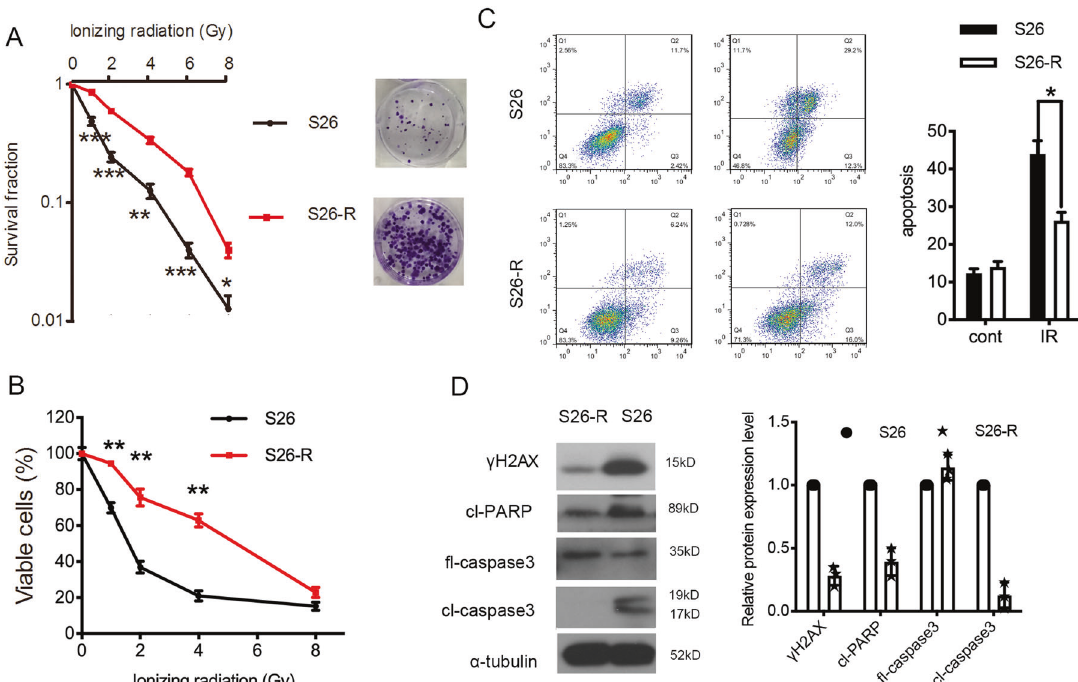
Fig. 1 Repeated ionizing radiation induces a risk of radioresistance in NPC cells. A (Left) Cell survival curve for treatment with increased doses of ionizing radiation in S26 and S26-R cells, * p < 0.05, ** p < 0.01, Student ’ s t -test. (Right) representative images of colonies formed after treatment with the indicated dose of ionizing radiation in S26 and S26-R cells. B A cell proliferation curve was constructed from the MTS assay results, data are presented as the mean ± S.D. values, ** p < 0.01, Student ’ s t -test. C , D S26 and S26-R cells were treated with or without 4 Gy of radiation for 48 h, then subjected to fl ow cytometry analysis of apoptosis * p < 0.05, Student ’ s t -test ( C ) and western blotting of the apoptotic markers ( D ); α -tubulin was used as loading control. (NPC, nasopharyngeal carcinoma; MTS, 3-(4,5-dimethylthiazol-2-yl) − 5-(3-carboxymethox- yphenyl) − 2-(4-sulfophenyl) − (Fig. 1B). To rule out that the effect is cell line speci fi c, we developed radioresistant SUNE1-R cells from another NPC cell line, SUNE1 (Fig. S1A, B). Radiation exerts its cytotoxicity by inducing apoptosis. When exposed to radiation treatment, radioresistant S26-R and SUNE1-R cells showed signi fi cantly decreased apoptosis and lower protein levels of H2AX variant histone ( γ H2AX), cleaved PARP, and cleaved caspase-3, which are all well-known markers of DNA damage and apoptosis, indicating reduced induction of cell death (Fig. 1C, D and Fig. S1C, D).